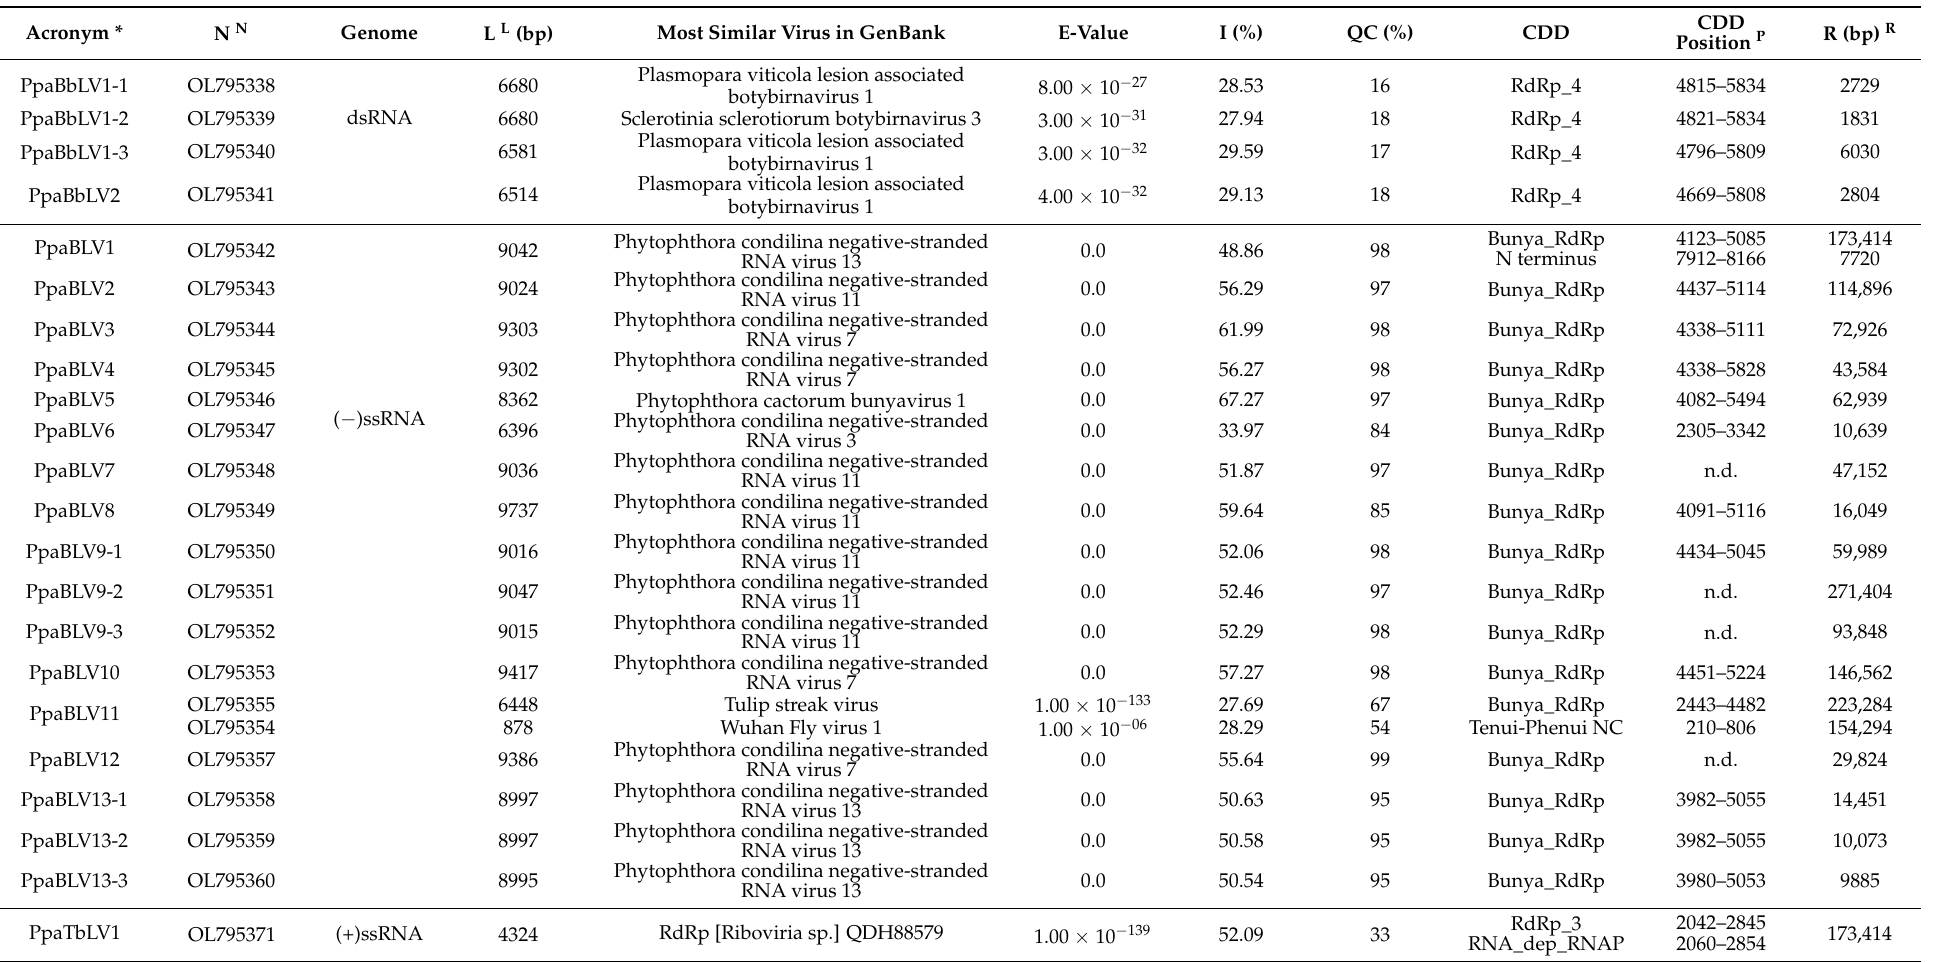
Table 1. GenBank most similar viruses to the putative “ Phytophthora palustris ” viruses based on BLASTX search and parameters of their genome